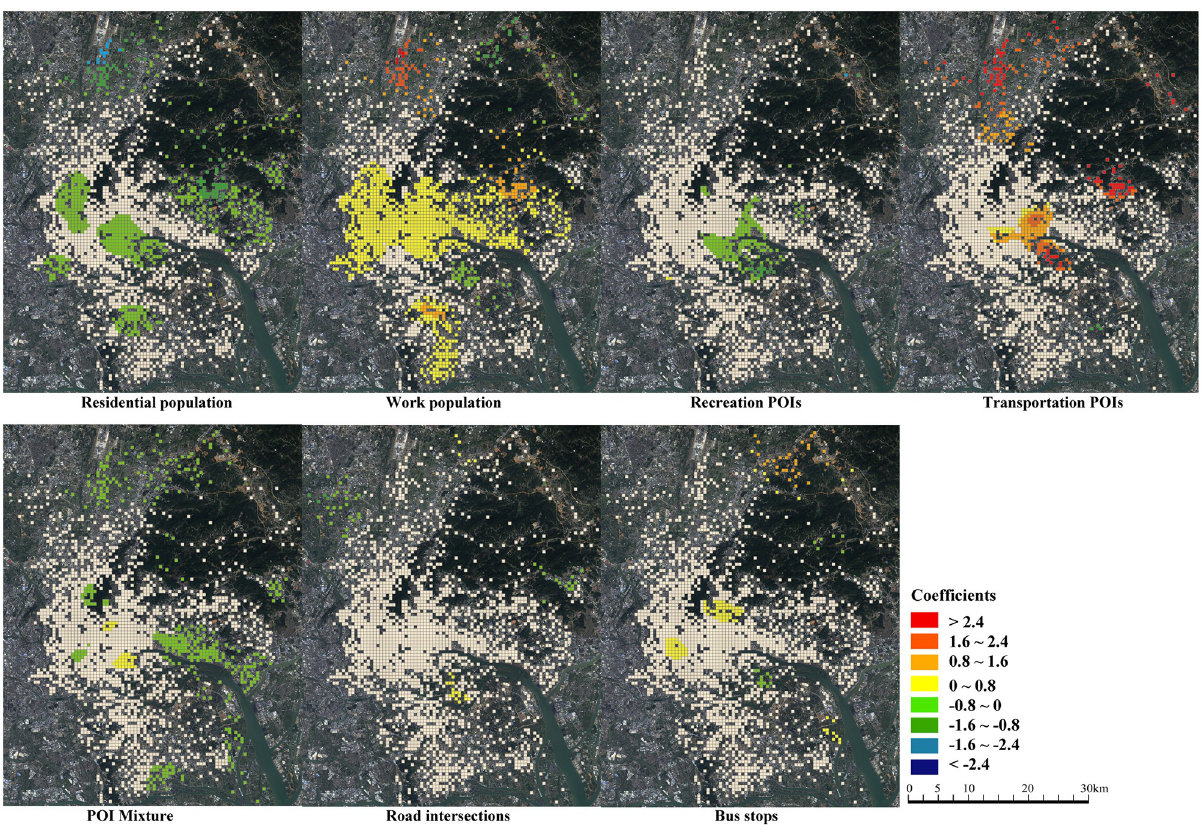
Fig 5. Distributions of coefficients in the work-based